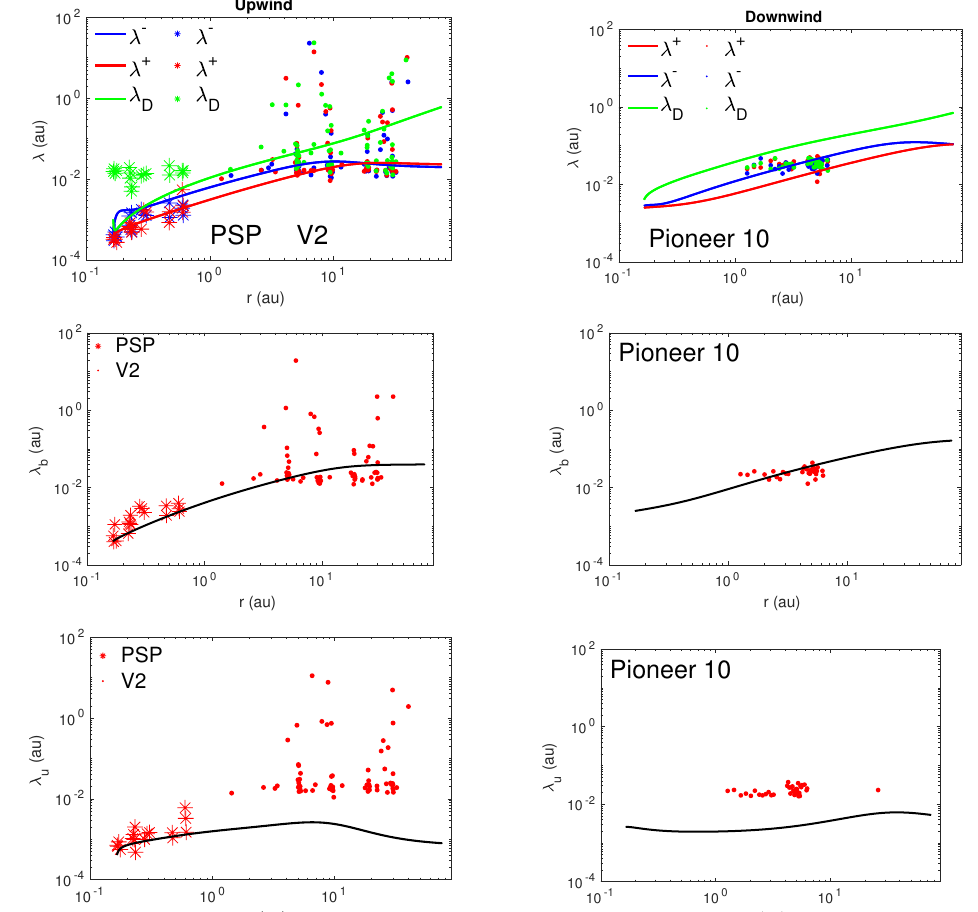
Figure 4. From top to bottom in the upwind direction ( left column) and downwind direction ( right column), the theoretical and observed correlation lengths corresponding to forward and backward propagating modes and the residual energy ( top panel), correlation length of magnetic field fluctuations ( middle panel), and correlation length of fluctuating kinetic energy ( bottom panel) are compared as a function of heliocentric distance, respectively. The solid curve denotes the theoretical correlation length. In the left column, the red, blue, and green “*” and “.” symbols represent the PSP and Voyager 2 measurements, respectively. In the right panel, the red, blue, and green “.” symbol represents the Pioneer 10